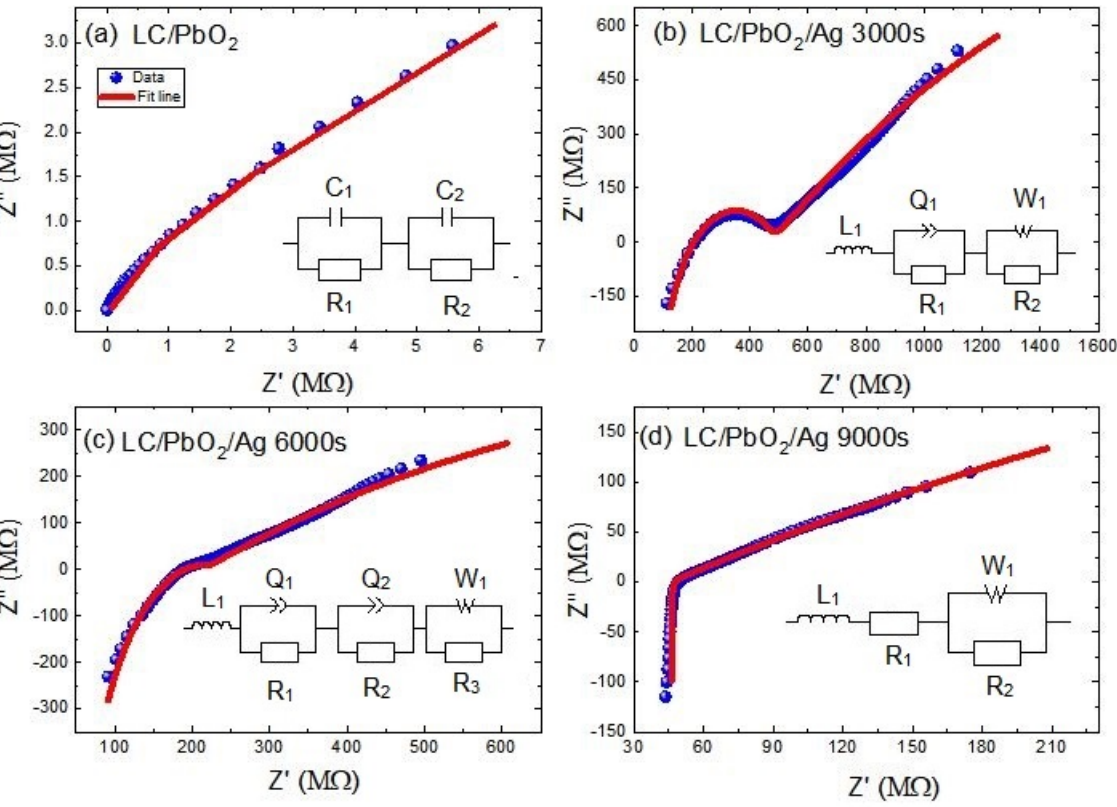
Figure 5. Impedance Nyquist plots of ( a ) LC \ PbO 2 sheet, ( b ) LC \ PbO2 \ Ag for 3000 s, ( c ) LC \ PbO 2 \ Ag for 6000 s, ( d ) LC \ PbO 2 \ Ag for 9000 s. The symbols show the experimental data and the solid lines represent the fitted curves according to the circuit shown in the insets.